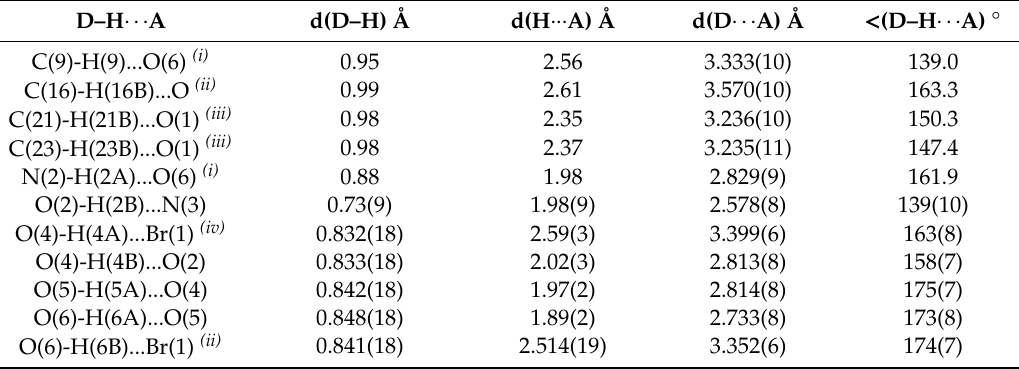
Table 3. Hydrogen bonding geometry for BTABr (e.s.d. values are in